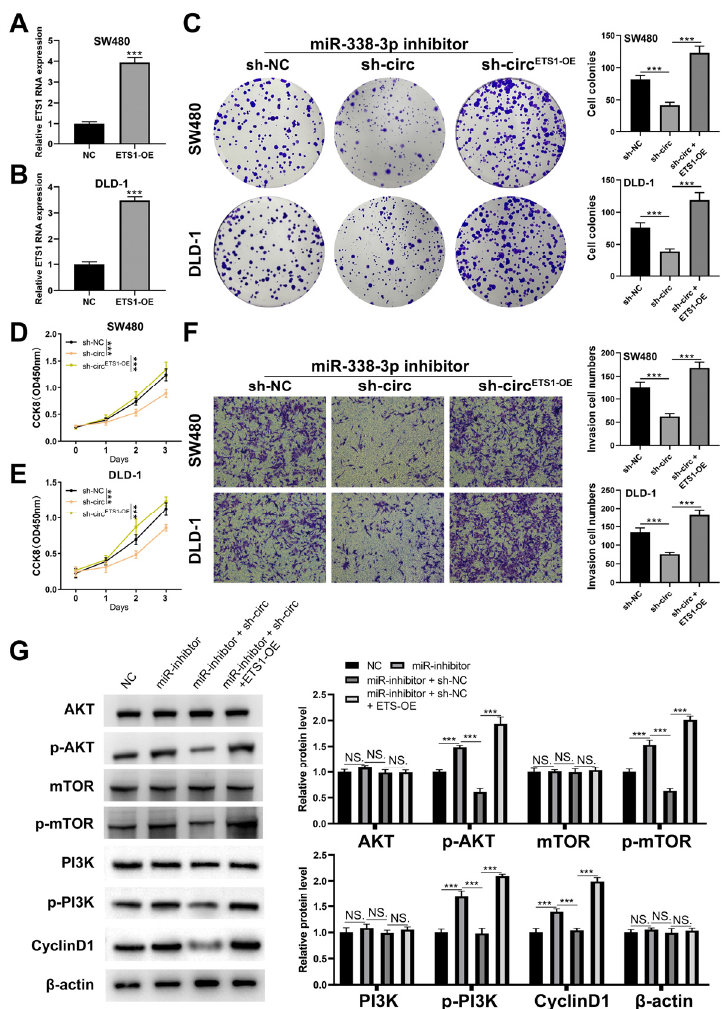
Figure 6. Hsa_circ_0008234 promotes colon cancer progression through miR-338- 3p/ETS1/PI3K/AKT axis. Notes: ( A , B ) qRT-PCR was utilized to evaluate the overexpression ETS1 efficiency, *** = p < 0.001; ( C ) Colony formation assay in cells with miR-338-3p inhibitor, miR-338-3p